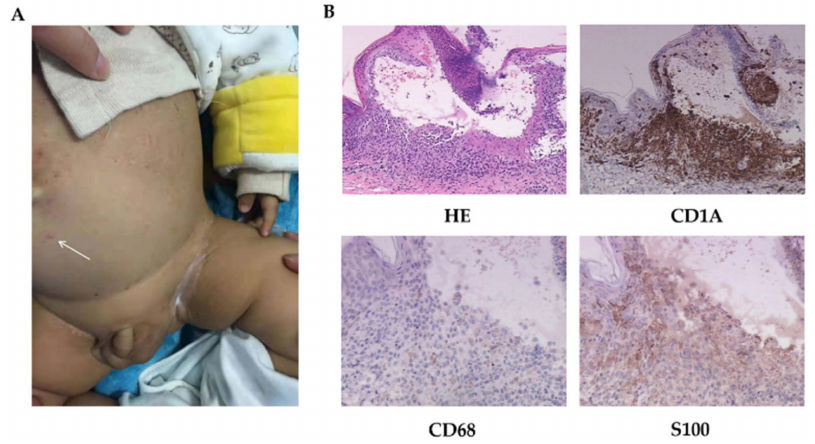
Figure 1. The skin manifestations and histopathology of patient 1. ( A ) Scattered vesicles (arrow) and papulovesicles on the abdomen. ( B ) HE-stained (200 × ) and immumohistochemical staining for CD1A (200 × ), CD68, and S100 (400 × ).